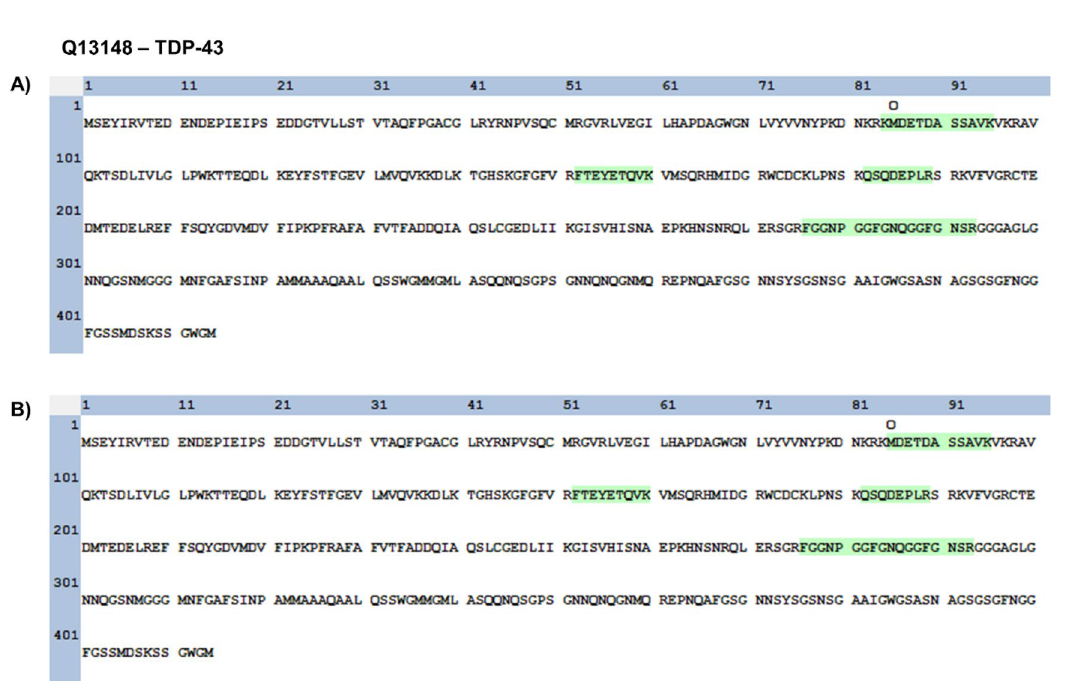
Figure 6. Identified tryptic peptides from TDP-43. The 90 kDa-tdTomato-TDP43 bands from cells transfected with the empty vector treated with MG132 ( A ) and overexpressed with p62 ( B ) were excised and underwent tryptic digestion. Peptide analysis indicated that the fragments consist of the C-terminal aa85-414 of